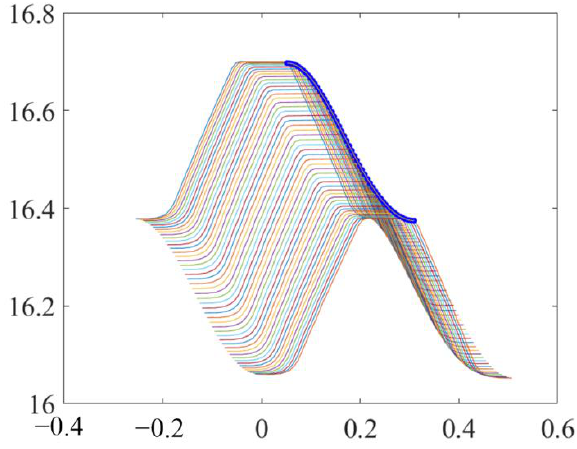
Figure 7. Rigid tooth profile fitted by the envelope method.